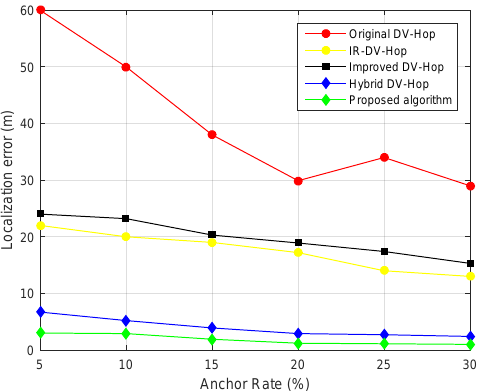
Figure 8. Localization error as function of anchor rate, with 100 sensor nodes and R = 30